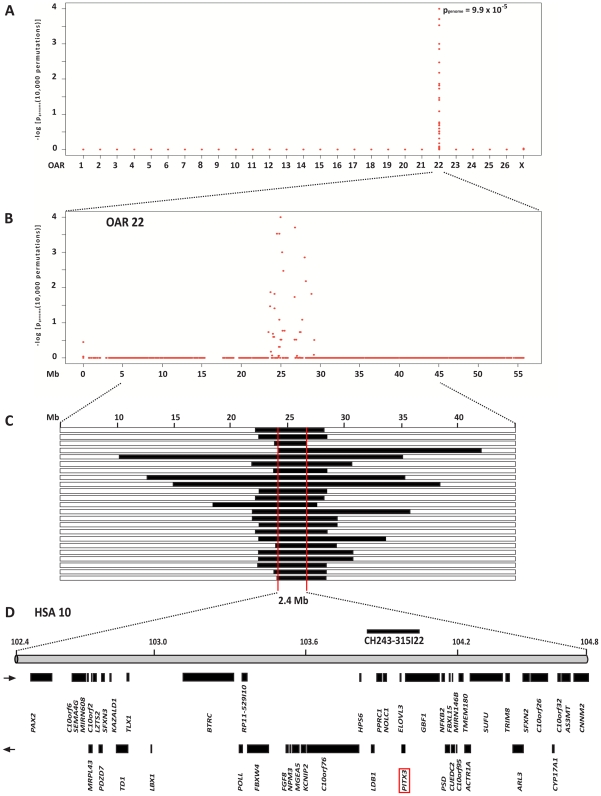
Genome-wide association mapping of microphthalmia.(A) Case-control whole genome association analysis finds significant association to SNPs on chromosome 22. (B) Single SNP association statistic across OAR 22. (C) Homozygosity mapping of the microphthalmia mutation. The analysis of SNP genotypes from affected sheep indicated that they had extended overlapping homozygous regions on OAR 22 (indicated as black blocks). Thus – assuming that it resides on the common haplotype block – the causative mutation is located within a 2.4 Mb interval on OAR 22 (indicated as red box). All 23 affected sheep had homozygous identical by state intervals with shared alleles between 24.5 Mb and 26.9 Mb. (D) Gene content of the corresponding human chromosome 10 segment.